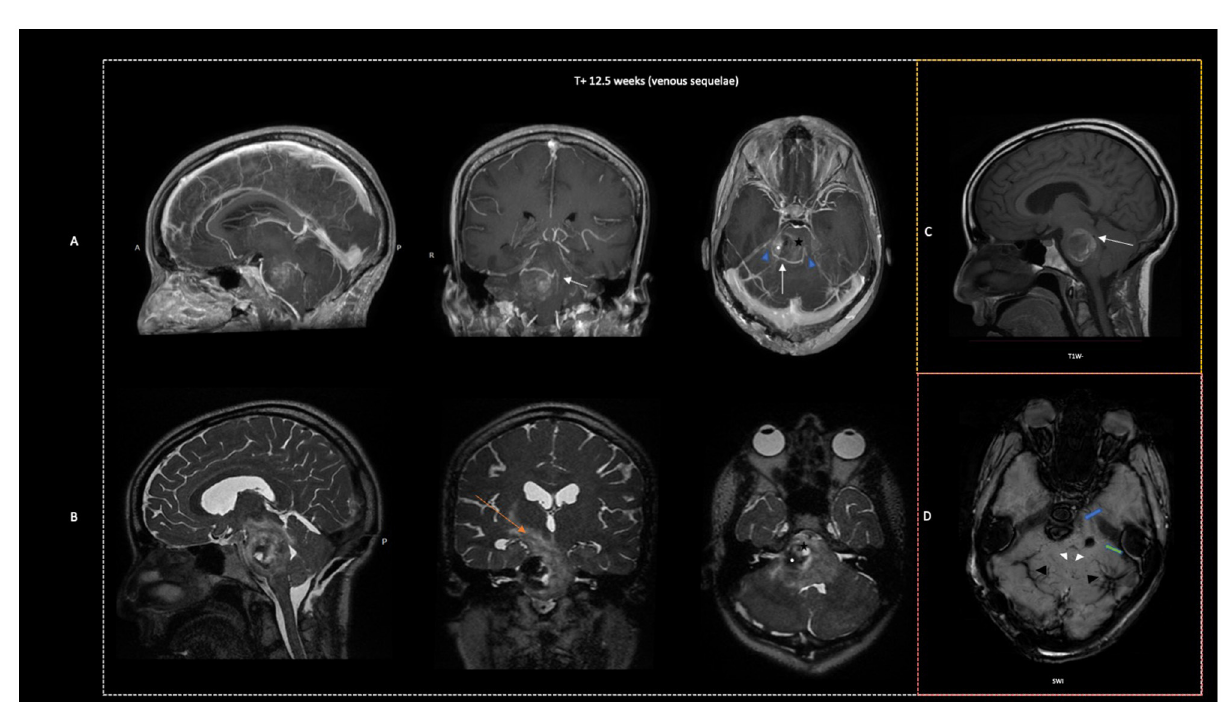
FIGURE4 Delayed venous congestion and hemorrhage after the second surgery. Sagittal, coronal, and axial MRI: (A) T1W + Gad; (B) T2W; axial only: (C) TW1 and (D) SWI. Marked edema extending from the pons, middle cerebellar peduncles to the cerebral peduncles and subthalamus (orange arrow) on T2W. Reduction in size of the surgical cavity with a small volume acute hematoma (black star) seen as T1W hyperintense and T2W hypointense signal, and early subacute hematoma (white star) with T1W + isointense and T2W hyperintense signal. The target CCM (blue arrow) appears to have been resected with no blooming artifact at this location seen on SWI. The contralateral CCM remains (green arrow) on SWI. Reduced filling caliber of main DVA draining vein on T1W + (white arrow) with outline present but no hypointense signal on SWI. Difficult to comment on the pressure of the DVA system in the presence of marked